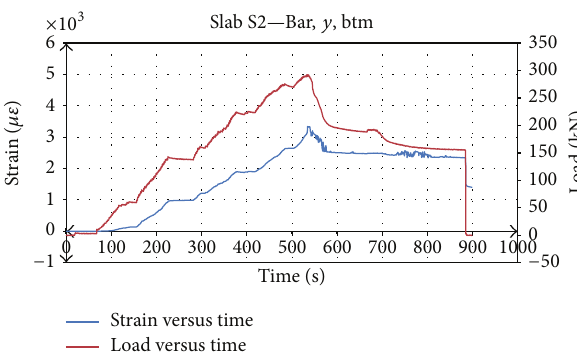
Figure 28: Time lapse for gauge 2.2 on Bar, 𝑦 , btm.